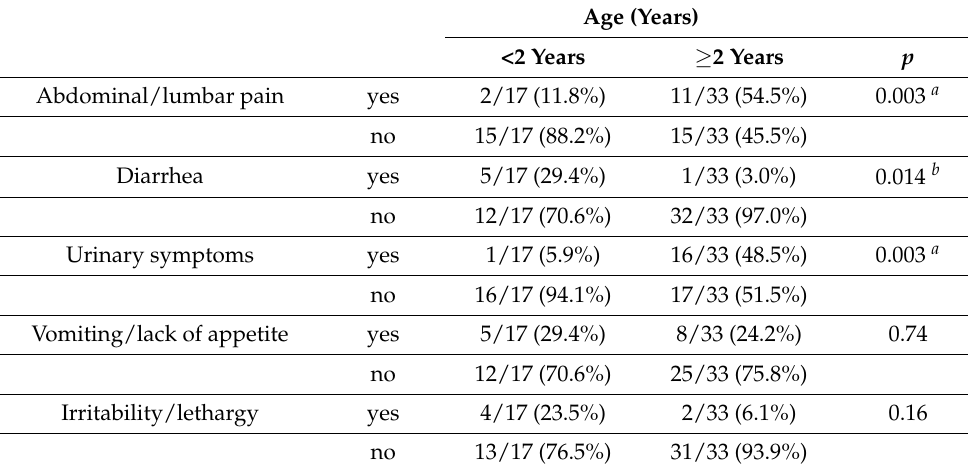
Table 2. Symptomatology ( n = 50) in relation to age (<2 years/ ≥ 2 years).